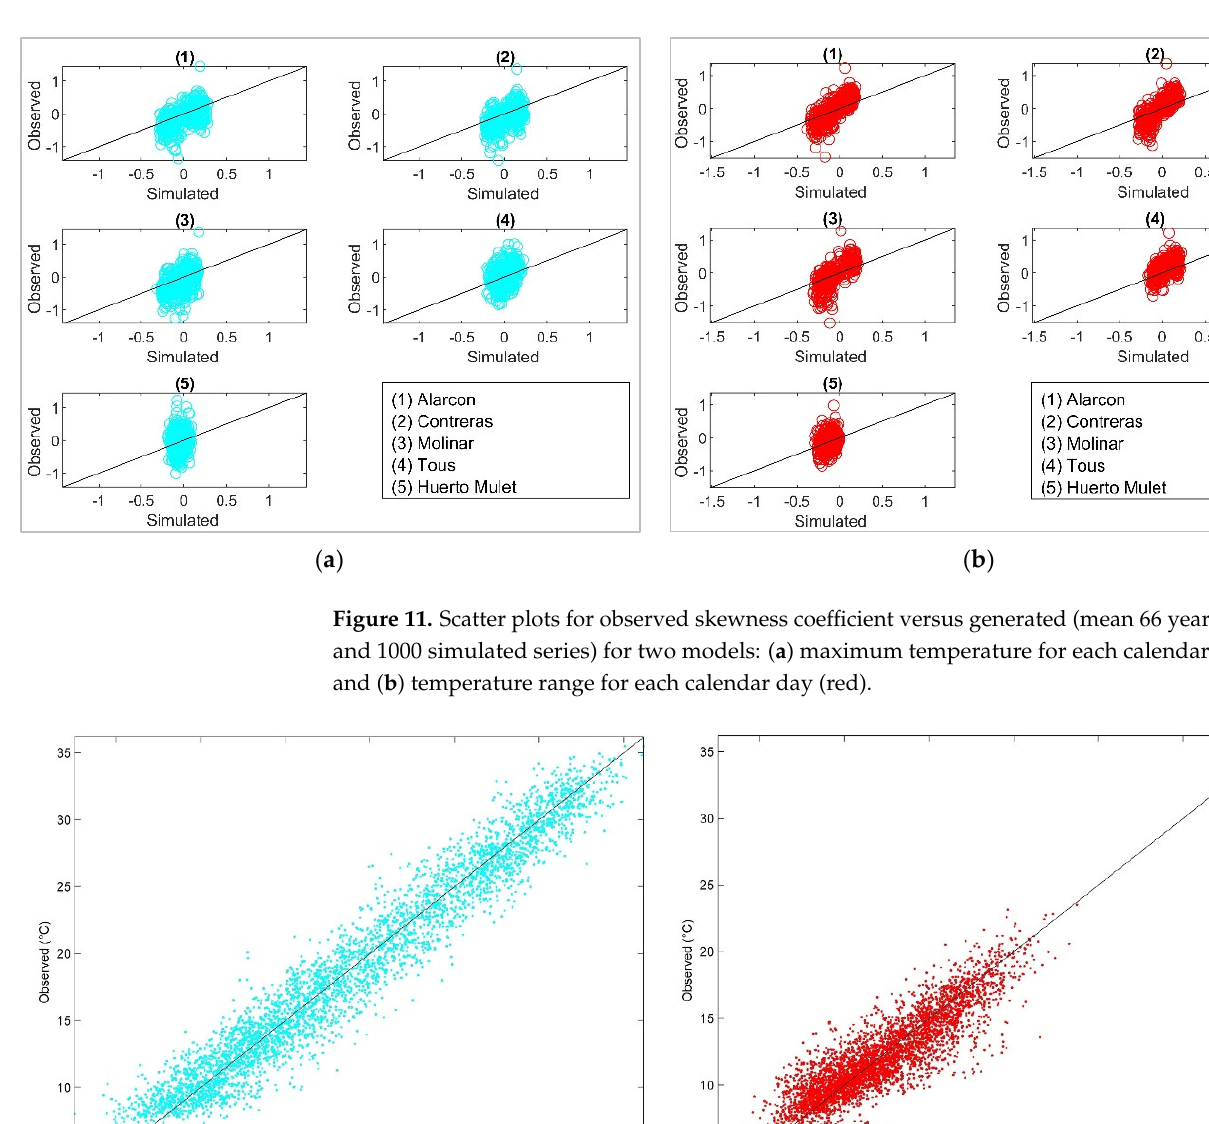
Figure 12. Monthly temperature for all sub-basins (mean 66 years observed and 1000 simulated series) observed and simulated for ( a ) maximum temperature for each month (blue) and ( b ) temperature range for each month (red), for 66 years, 5 sub-basins, and all months.